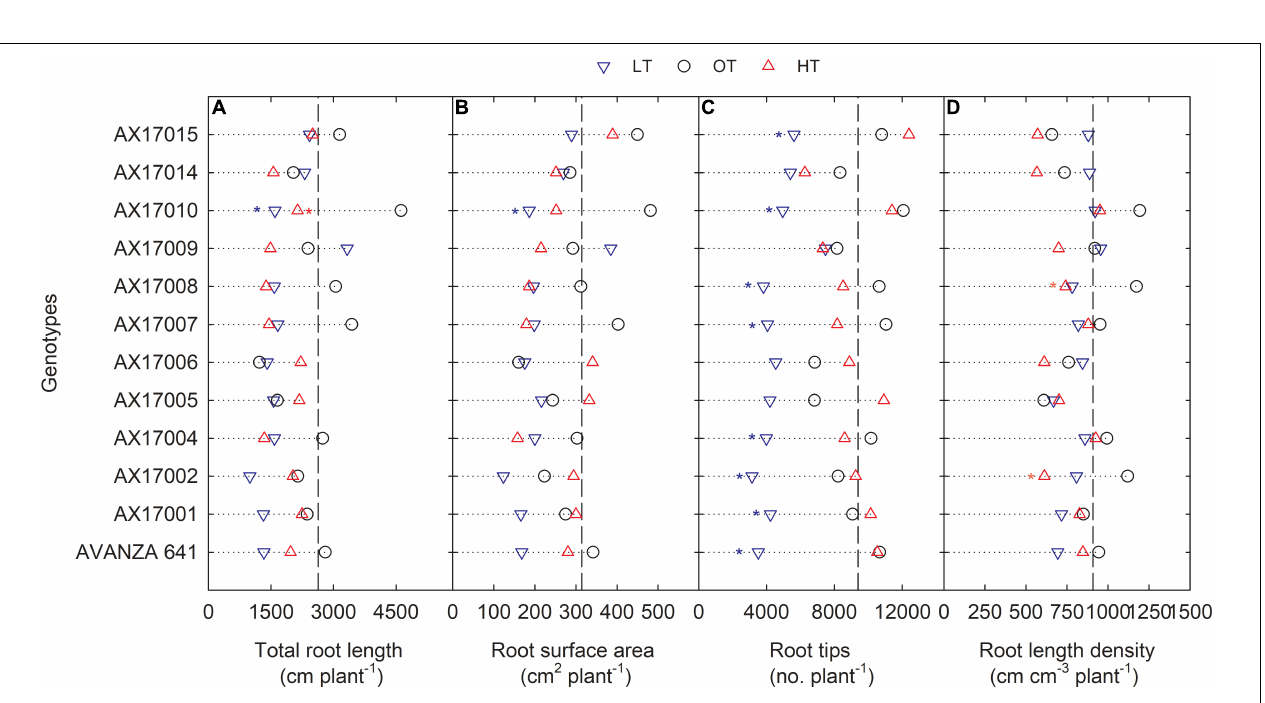
Frontiers in Plant Science |